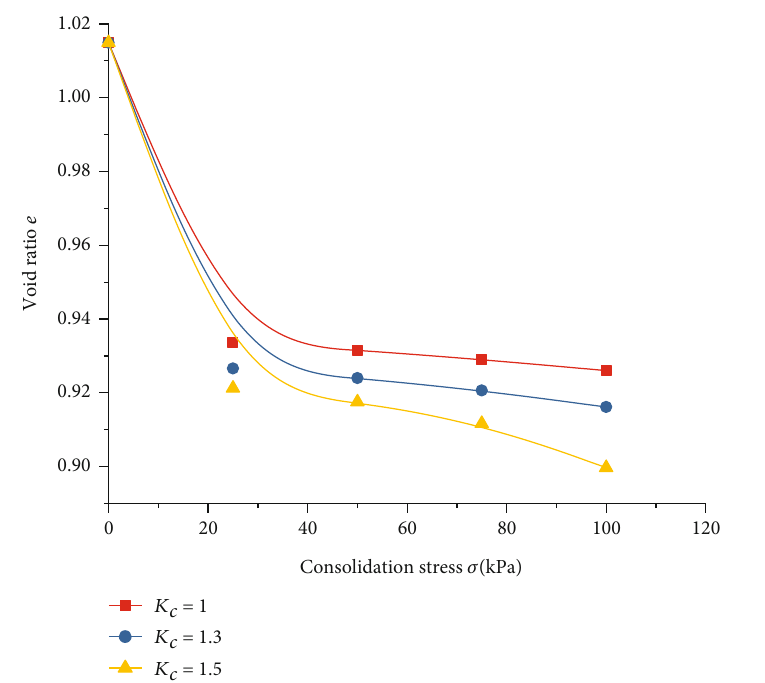
Figure 14: The curve of the void ratio of overconsolidation clay with consolidation pressure at di ff erent consolidation stress